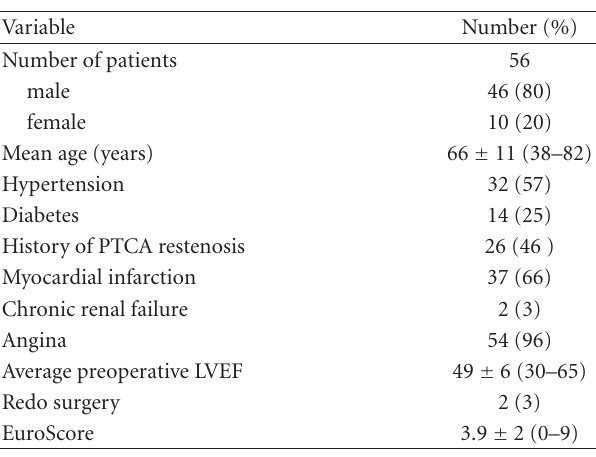
Table 1: Patient Demographics.